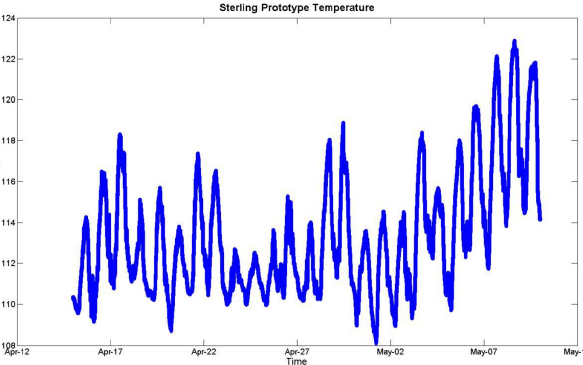
Fig. 3. Time series of platinum resistance thermometer (PRT) ob- servations in April–May 2011 from Domain 10: North Sterling, Colorado. These data were intentionally not calibrated and contain known